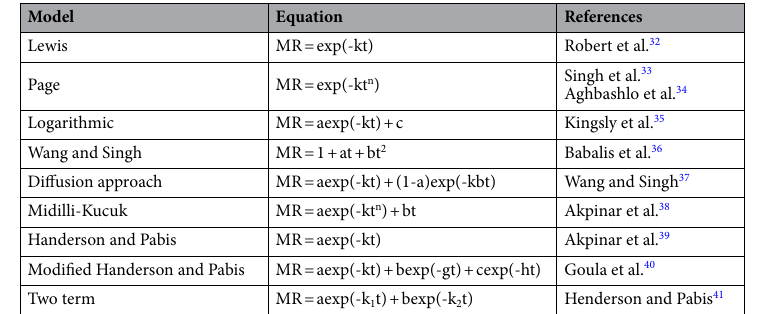
Table 2. Mathematical models applied to fig drying